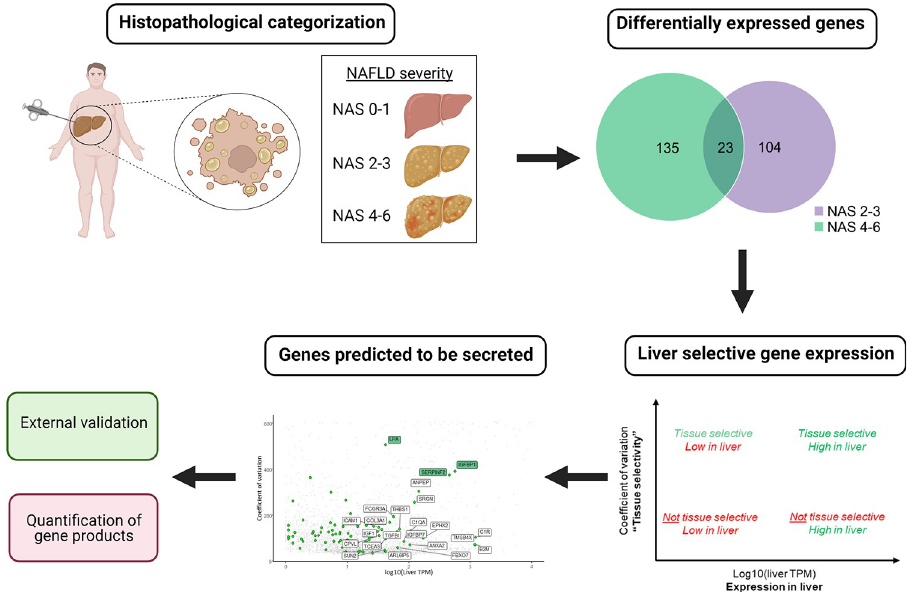
Fig 1. Overview of the concept for identifying potential, circulating biomarkers of NAFLD. Liver secretome gene signatures were generated from DEGs between individuals with no/mild NAFLD and moderate to advanced NAFLD with subsequent filtering for candidate gene products with liver-selective expression and secretion. Abbreviations: DEGs, differentially expressed genes; NAFLD, non-alcoholic fatty liver disease; NAS, NAFLD activity score. Created with